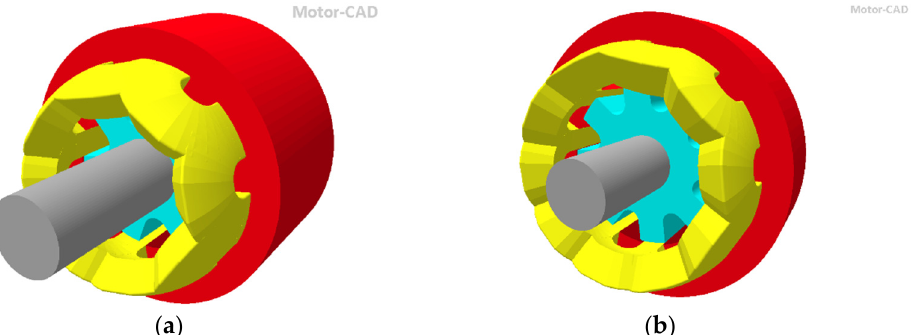
Figure 20. 3D models procured for analysis of SRM motor variants with straight poles: ( a ) 8/6; ( b ) 10/8.